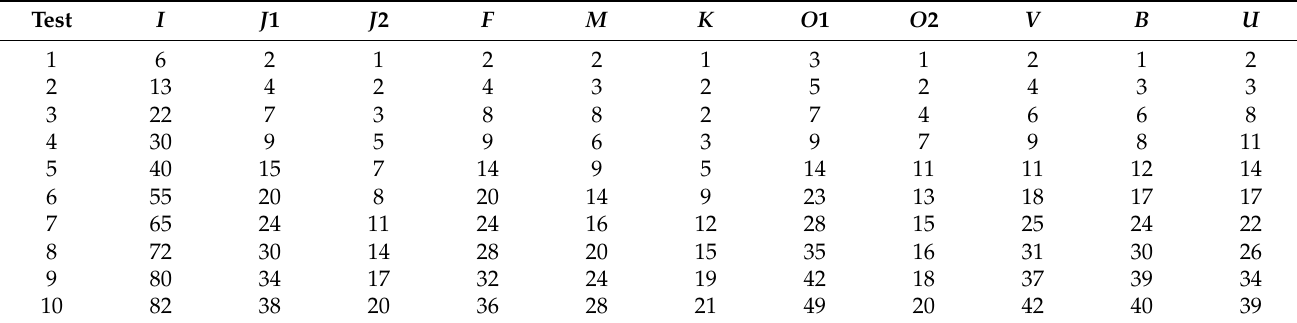
Figure 13. Major cities of Mazandaran Province. Table 4. General data of test